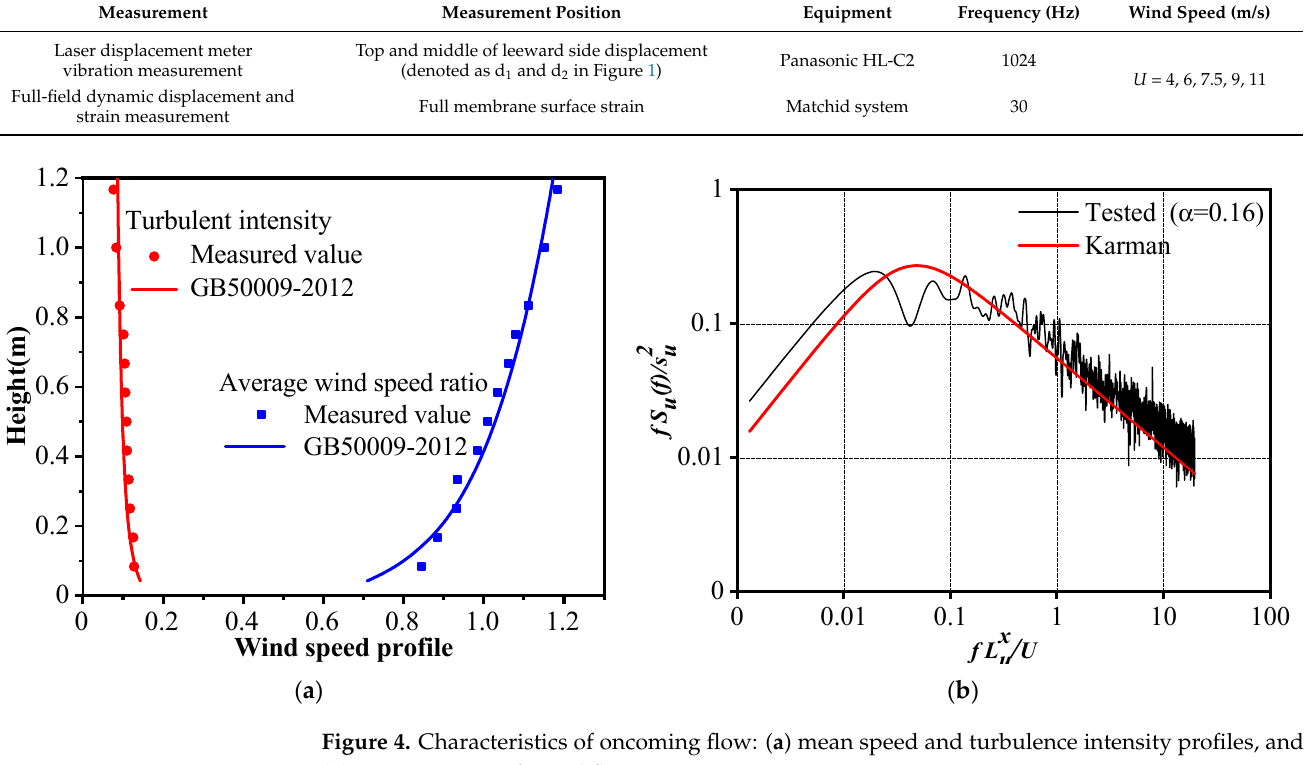
Figure 4. Characteristics of oncoming flow: ( a ) mean speed and turbulence intensity profiles, and ( b ) power spectra of speed fluctuation at H = 0.4 m.